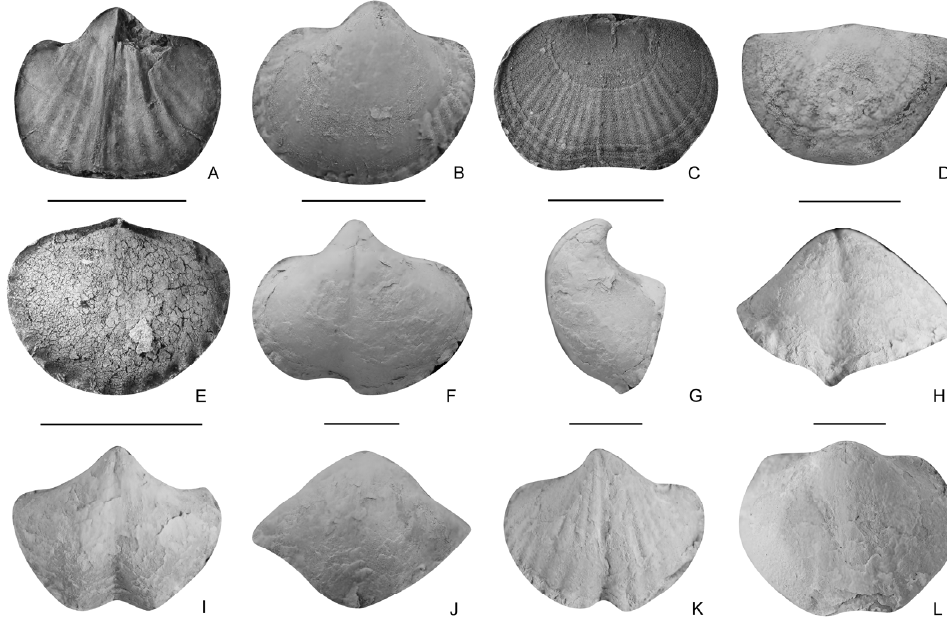
Figure 6. ( A – E ), Hirsutella rectimarginata , ( A ), an internal mould of a ventral valve, LD380429; ( B ), a ventral valve, LD383507; ( C ), an external mould of a dorsal valve, LD380440; ( D ), a dorsal valve, LD384020; ( E ), an internal mould of a dorsal valve, LD380253. ( F – L ), Hirsutella sulcata sp. nov., ( F – K ), ventral valves, ( F ), LD383719, ( I ), LD384237, ( K ), LD384281; ( G , H ), lateral and anterior views of ( F ); ( J ), anterior view of ( I ); ( L ), a dorsal valve, LD383526. Scale bar = 5 mm. Remarks. The present species is similar to Hirsutella extraruga (Yang and Yin in Yang, et al., 1962) [49] in shell outline and lateral profile, but it has a more distinct sulcus and an extended median tongue occasionally developed in the ventral valve. Hirsutella hirsuta (Alberti, 1864) [50] is similar to the present species in shell outline and development of ventral sulcus, but differs by having a more elevated ventral beak. The current species is similar to Sinucosta bifucata Sun and Shi, 1985 [51] from the upper Triassic of Yunnan, China, in the rounded subpentagonal outline and moderately developed costae, but the former has a wider hinge, coarser costae and more distinct fold and sulcus. The Datuguan specimens resemble Mentzelia subspherica Yang and Xu, 1966 [52] from the Anisian of Guizhou, south China, in semicircular outline and sulcus beginning from beak, but the latter has more costae than most of the Datuguan specimens and developed spondylium. It is similar to Dagyssia multicostata (Yang and Xu, 1966) [52] from Qinghai, China, in the similar outline and feebly developed costae, but the latter has less developed sulcus and fold and more number of costae.